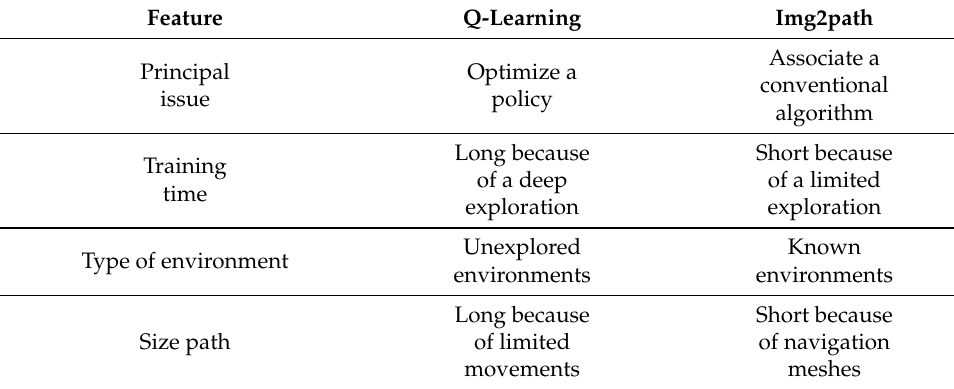
Table 5. Comparative of features about auto-encoder with Q-learning